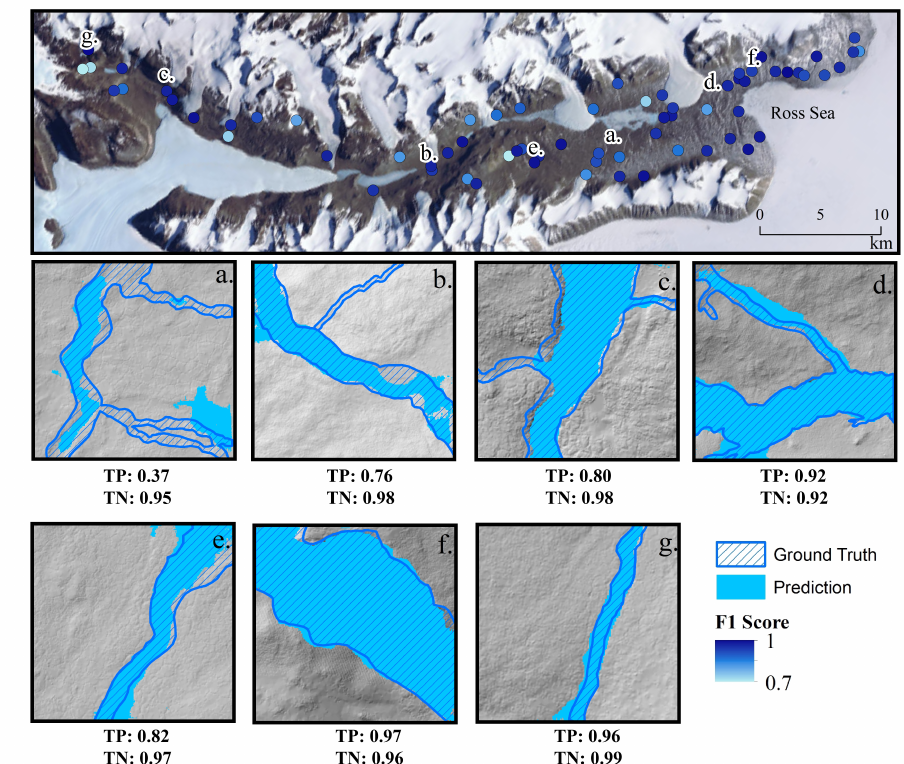
Figure 6. Spatial performance of stream boundary prediction for the elevation-based model. The points represent the F1 score from low (white) to high (blue). The F1 score was found to decrease inland. ( a – g ) are examples of stream prediction with their true positive and true negative performances. These examples are pretty indicitive of the valley where there is some underprediction, but not as much overprediction. Underprediction and overprediction is typically situated on the smaller tributaries. ( a – g ) show the prediction of stream boundaries in light blue overlain by the ground truth outlined in dark blue with stripes. Underlain is the 2014 hillshade for